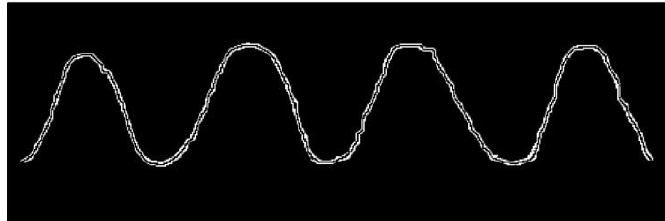
Figure 9. Obtained image using the first four morphological transformation operations